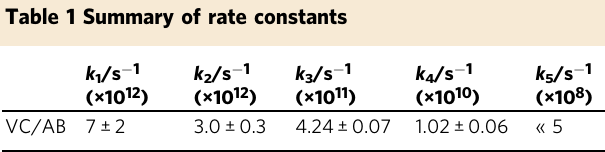
Table 1 Summary of rate constants